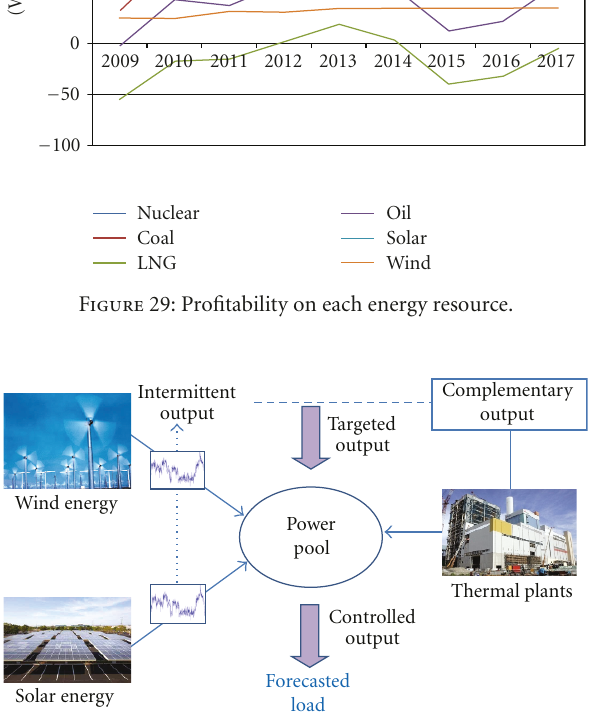
Figure 30: Renewable thermal coordinated operation.